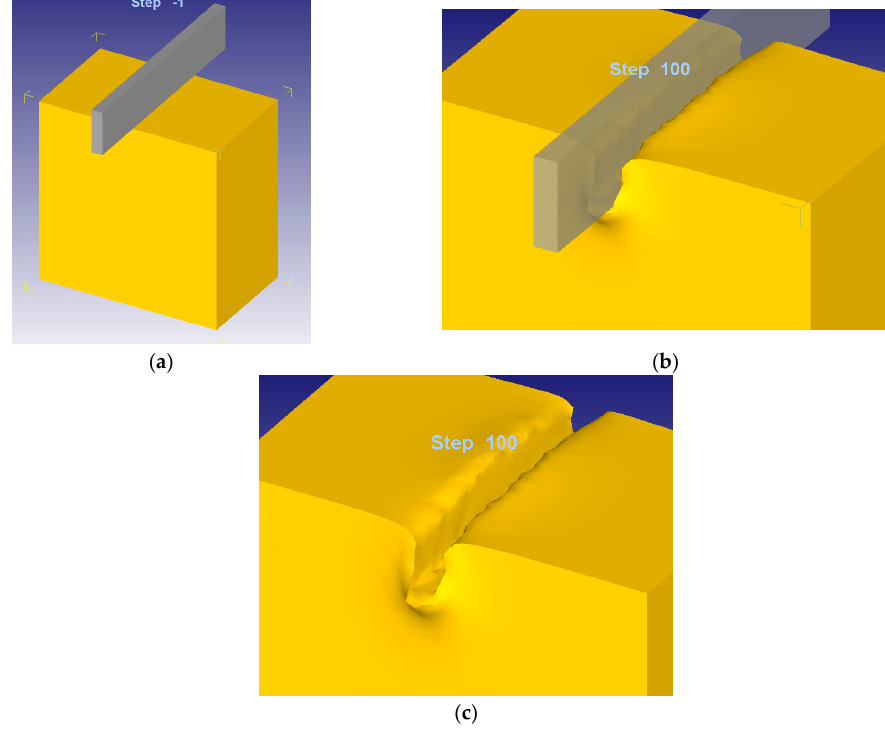
Figure 3. A 3D FEM model of the 50 × 50 × 30 mm sample and indenter: before indenting ( a ); during indentation process ( b ); and workpiece after indentation ( c ).